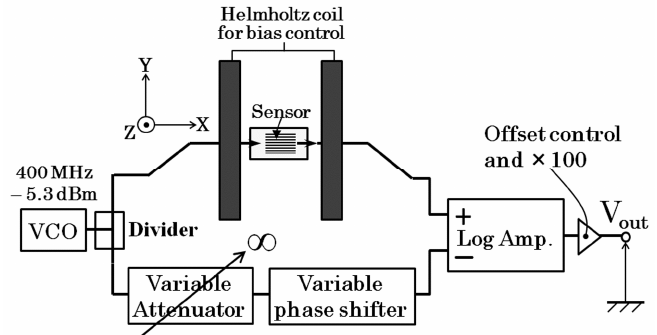
Figure 6. Method of confirmation of certainty of the output of sensor system.